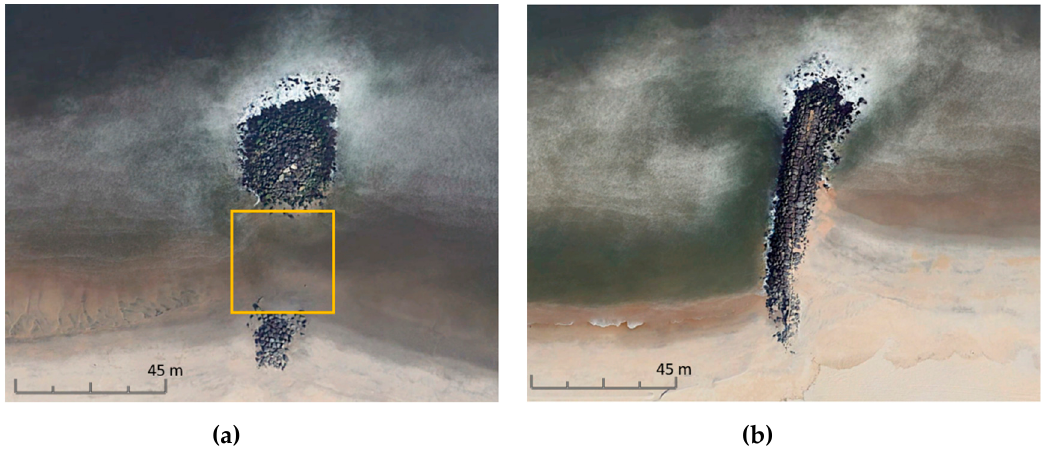
Figure 3. Unmanned Aerial Systems (UAS) aerial images of: ( a ) Notched groin at Deal beach with a box depicting the notch area or the section of groin removed; ( b ) Typical traditional groin at Deal beach.